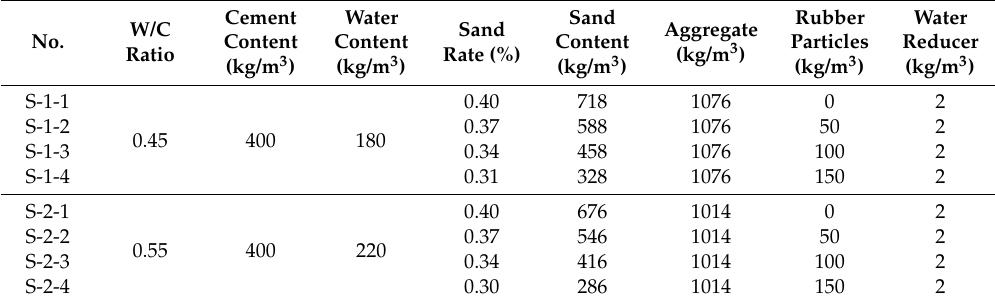
Table 1. Ratio of rubber aggregate concrete beams.